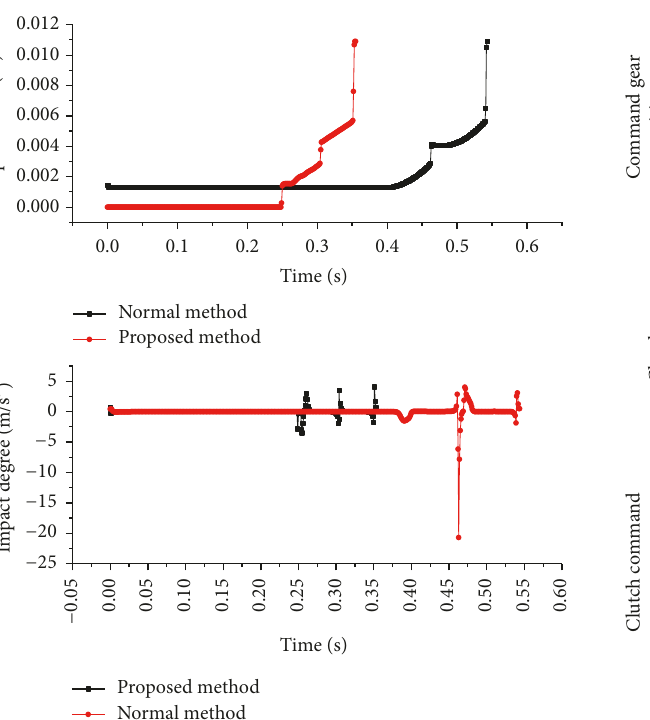
Figure 21: Clutch state and gear state in upshift